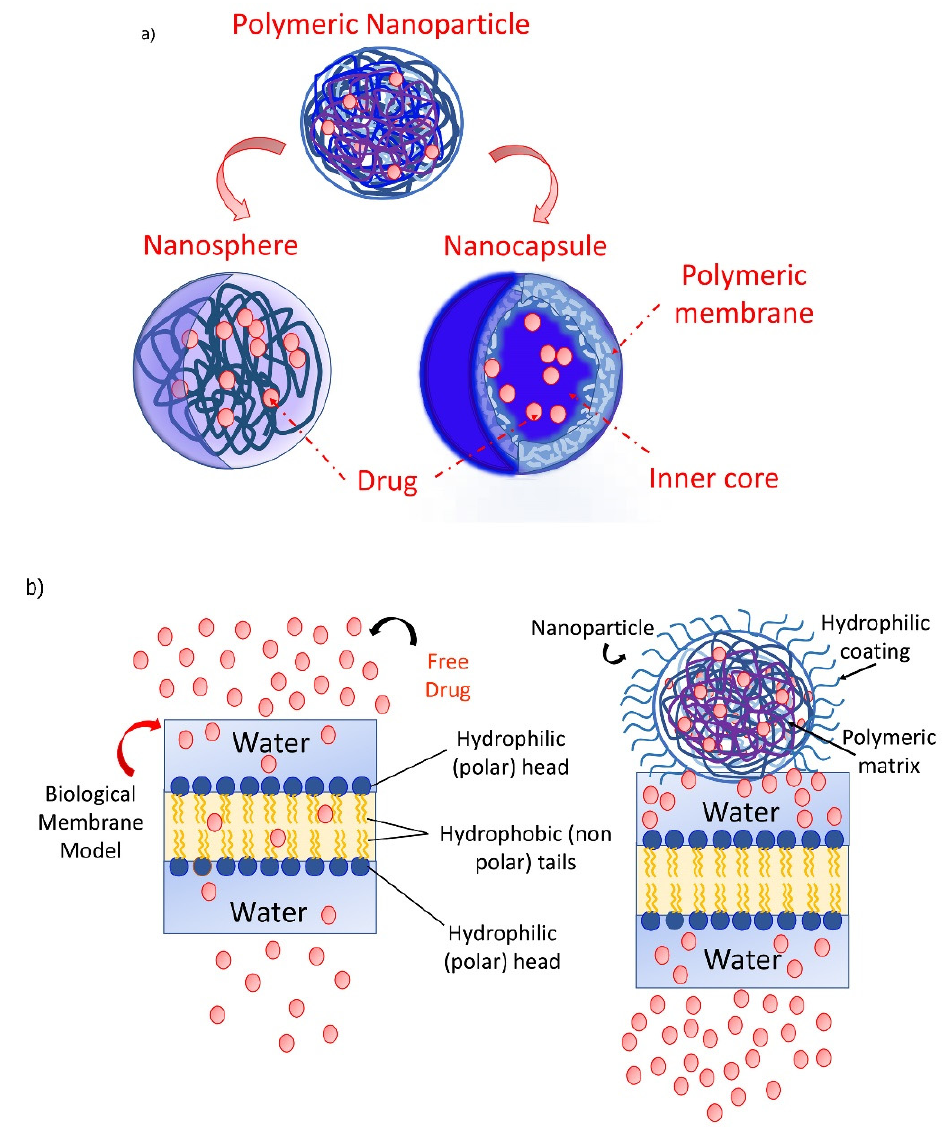
Figure 11. ( a ) Schematic representation of polymeric nanoparticles and ( b ) a model of the interaction between the aqueous phase containing a free hydrophilic drug or drug-loaded nanoparticle and the biological membrane model.